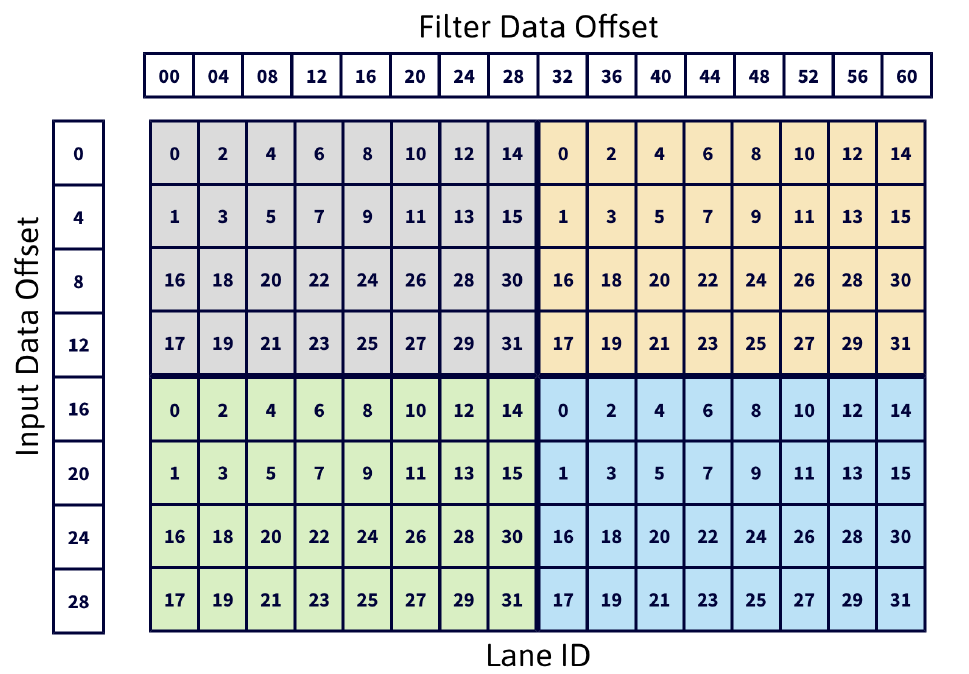
Figure 4. Lane ID arrangement for the data transposing buffer.